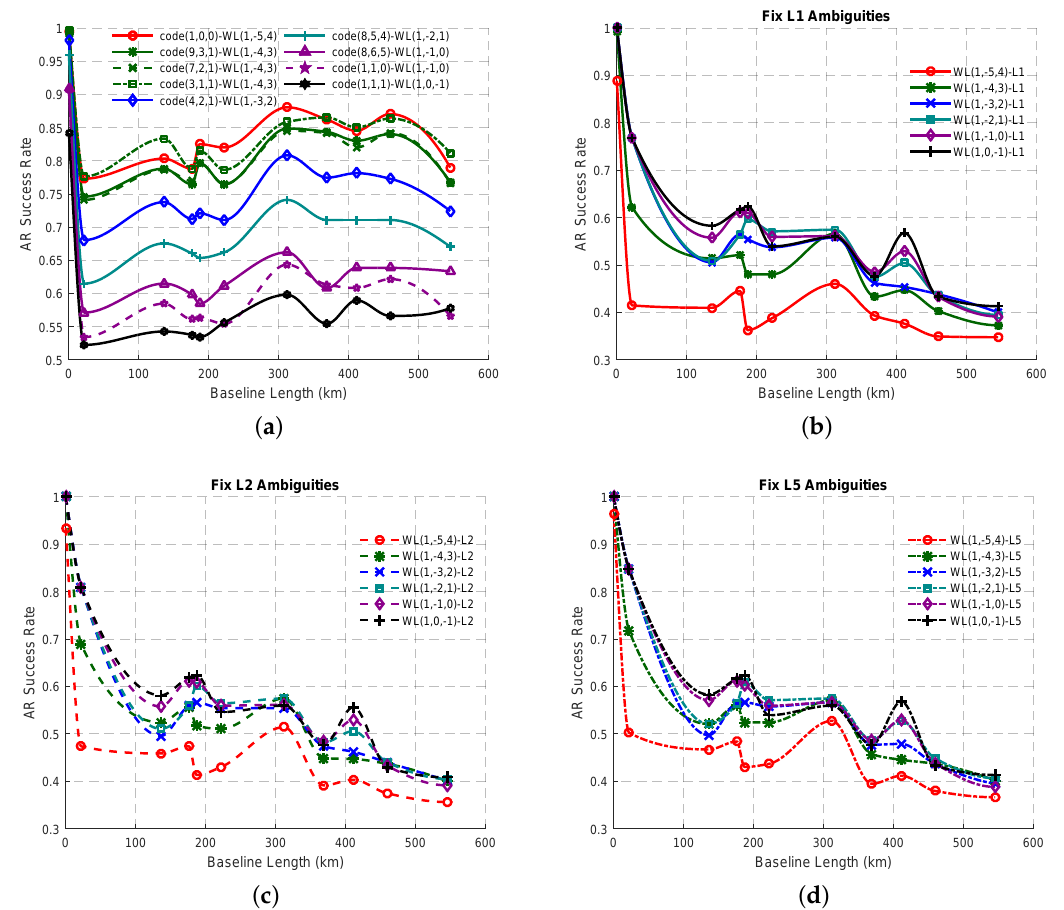
Figure 10. The variation trend of AR success rate in GF TCAR. ( a ) The signal pair with combined code and WL carrier phase; ( b – d ) The signal pairs with ambiguity corrected WL carrier phase signal and fundamental signals L1, L2 and L5